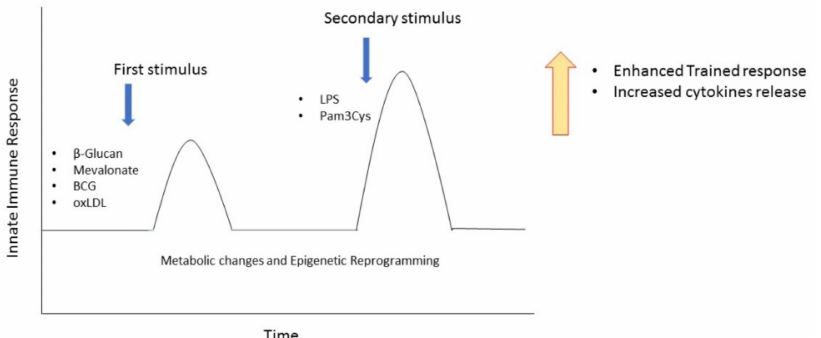
Figure 2. Induction of trained immunity in monocytes. Repeated stimulation of monocytes with β -Glucan, Mevalonate, BCG, or oxLDL determines an enhanced proinflammatory response af- ter a secondary stimulus. Arrows represent the moment of the first and the second stimulation. BCG, bacillus Calmette–Gu é rin; oxLDL, oxidized low-density